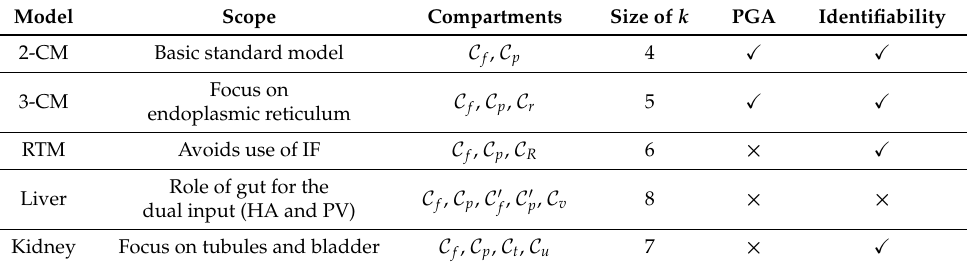
Table 1. Comparison among different compartment models. For each of the models we summarize the main characteristic ( Scope ), the involved tracer compartments ( Compartments ), and the number of unknow rate constants to be estimated ( Size of k ). The last to columns indicate whether the Patlak graphical approach can be applied ( PGA ), and whether the identifiability of the considered model has been proved ( Identifiability